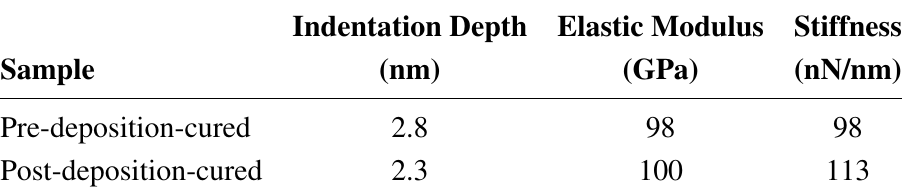
Table 1. Average indentation depths, elastic moduli and stiffness for each sample. Statistical information about these averages is provided in the text and in Figure